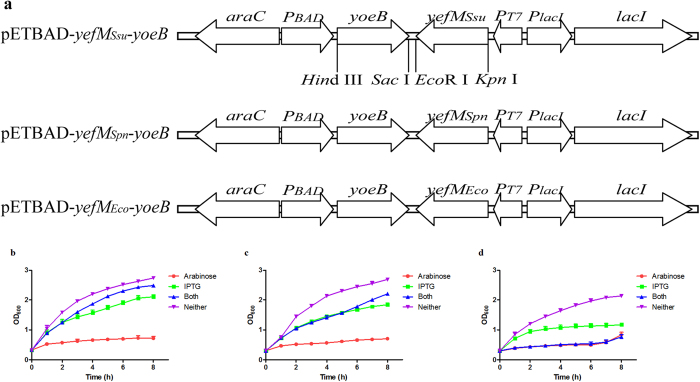
Toxicity of YoeBSsu can be alleviated by YefMSsu and YefMSpn, but not by YefMEco.E. coli BL21(DE3) cells harbouring the respective selective expression plasmids were grown to an OD600 of about 0.3. Each culture was then divided into four equal parts, to three of which were individually added 0.2% L-arabinose, 1 mM IPTG or both, respectively. The fourth part served as the control, to which nothing was added. These cultures were further incubated and samples were taken every hour to determine the OD600. (a) Schematic representation of plasmids for the selective expression of YefM and YoeB under the control of PBAD and Plac, respectively. (b) Toxicity of YoeBSsu can be alleviated by YefMSsu. (c) Toxicity of YoeBSsu can be alleviated by YefMSpn. (d) Toxicity of YoeBSsu cannot be alleviated by YefMEco. The data shown are averages with standard deviations for the results from three independent experiments.